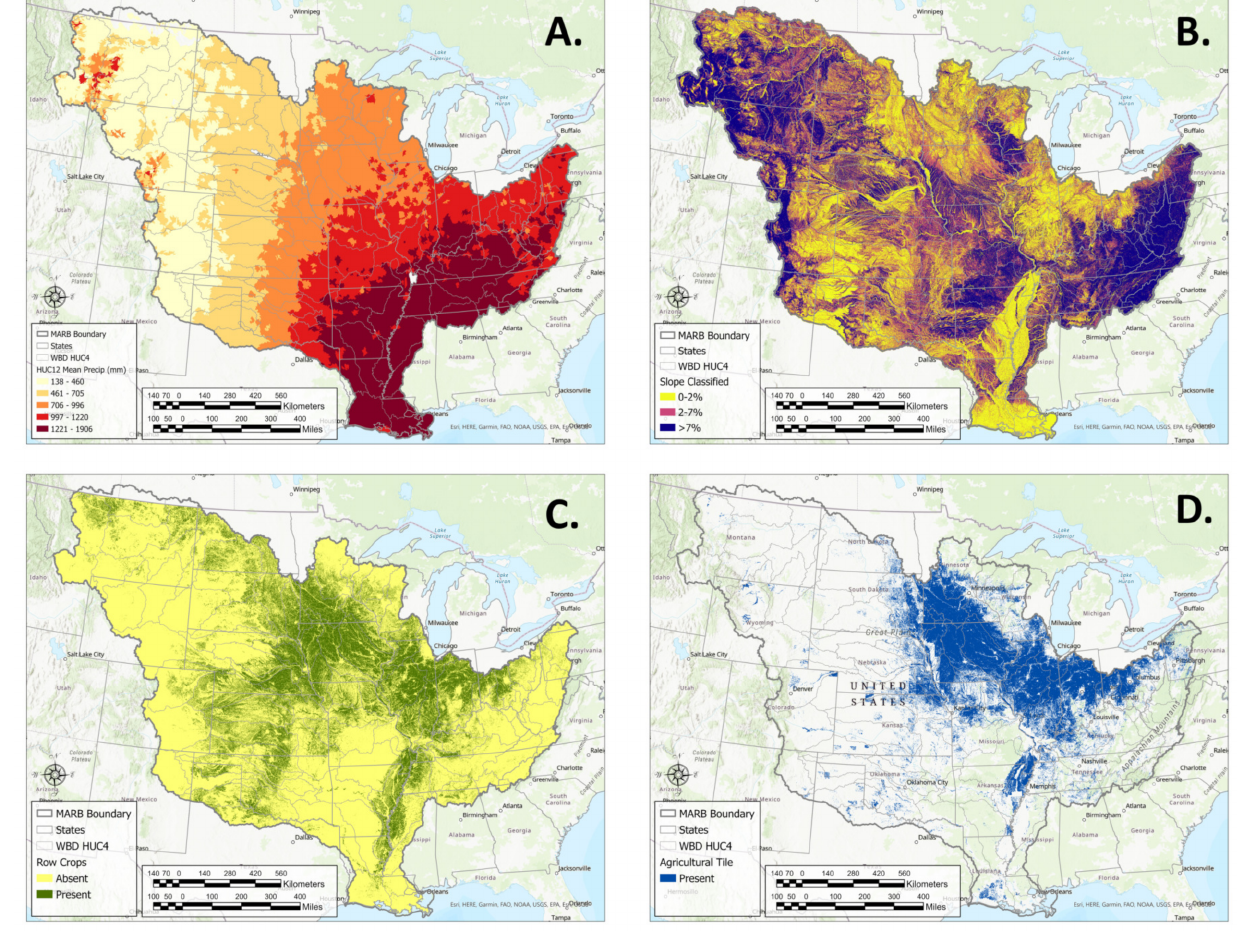
Figure 1. Spatial patterns of annual precipitation ( A ), land slope ( B ), row crop land cover ( C ), and subsurface tile drainage ( D ) in the